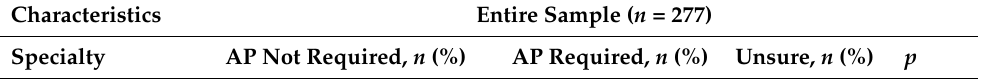
Table 8. Association between the specialists and their response to questions in Table